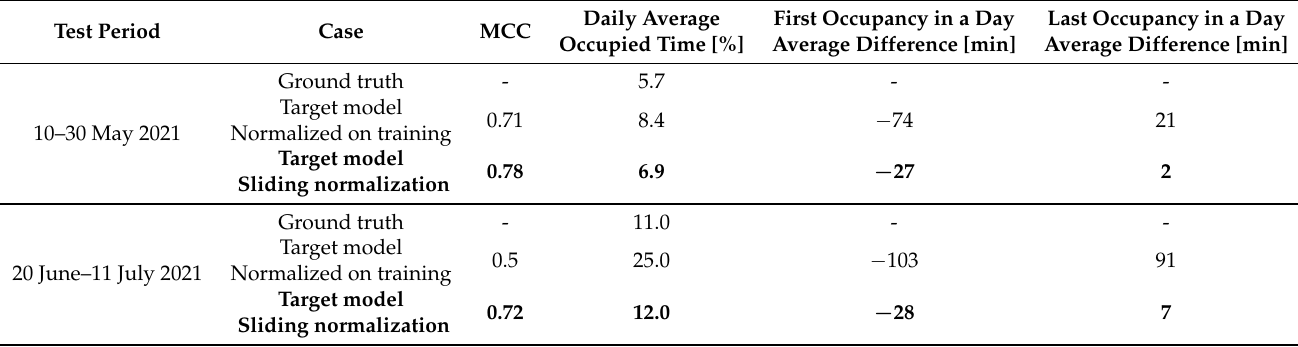
Table 5. Performance of target model after the room ventilation changed from constant to variable airflow rate operation